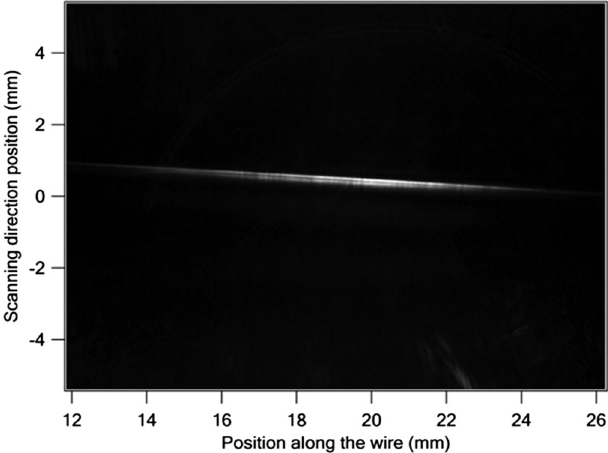
FIG. 5. Image of the carbon wire at rest taken during the bench test depicted in Fig. 4.